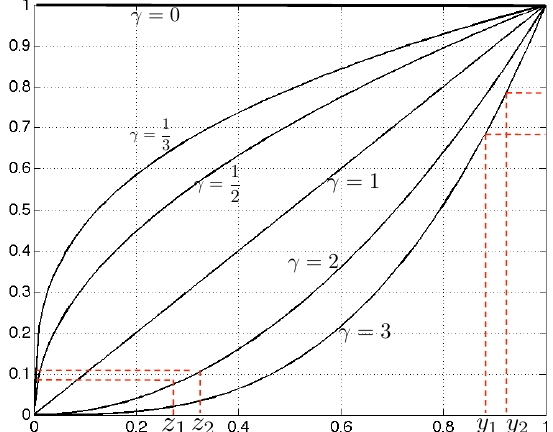
[0 , 1] with warping factors γ = 1 , 2 , 3 , 1 ∈